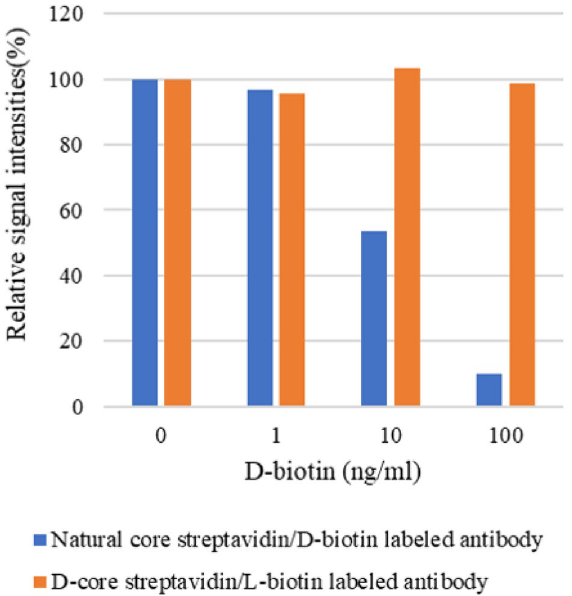
Figure 4. The effects of D-biotin added in the specimens for immunoassay. Horizontal axis: D-biotin concentration added in TSH specimens. Vertical axis: Relative signal intensities with various D-biotin concentrations added (D-biotin concentration: 0 nM, 100%). All values in the figure are expressed as mean from duplicated